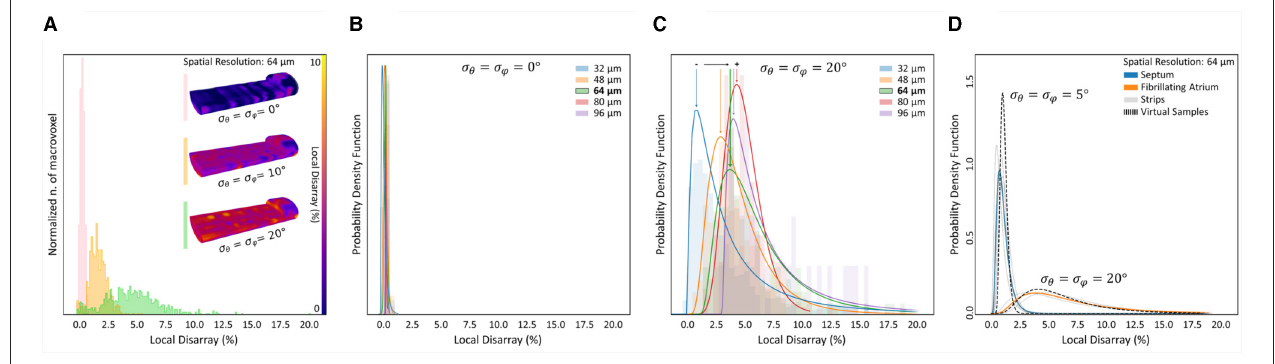
FIGURE 9 | Evaluation of cellular angular dispersion by means of virtual samples generation. Artificial samples of 1,300 different ( σ θ , σ ϕ ) values to estimate the actual 3D myocyte angular dispersion by the local disarray distributions found in control and pathological samples. (A) Disarray analysis is performed with a fixed resolution of 64 µ m on three artificial samples created with σ θ disarray is shown partially cutted along the image plane, and the distributions of the local disarray values are shown. (B,C) The dependence between disarray distribution and spatial resolution is confirmed only in disordered citoarchitectures using log-normal PDF to fit disarray in two virtual samples with σ θ (ordered, B ) and 20 ◦ (disordered, C ). (D) Log-normal PDF of cellular disarray at 64 µ m is shown for each cardiac tissue strip (gray curves). Average PDF is calculated for control (blue) and pathological (orange) strips. The cellular angular dispersion in the tissue is extracted comparing the disarray PDF of two artificial samples with σ θ σ ϕ 5 ◦ (control) and 20 ◦ = =